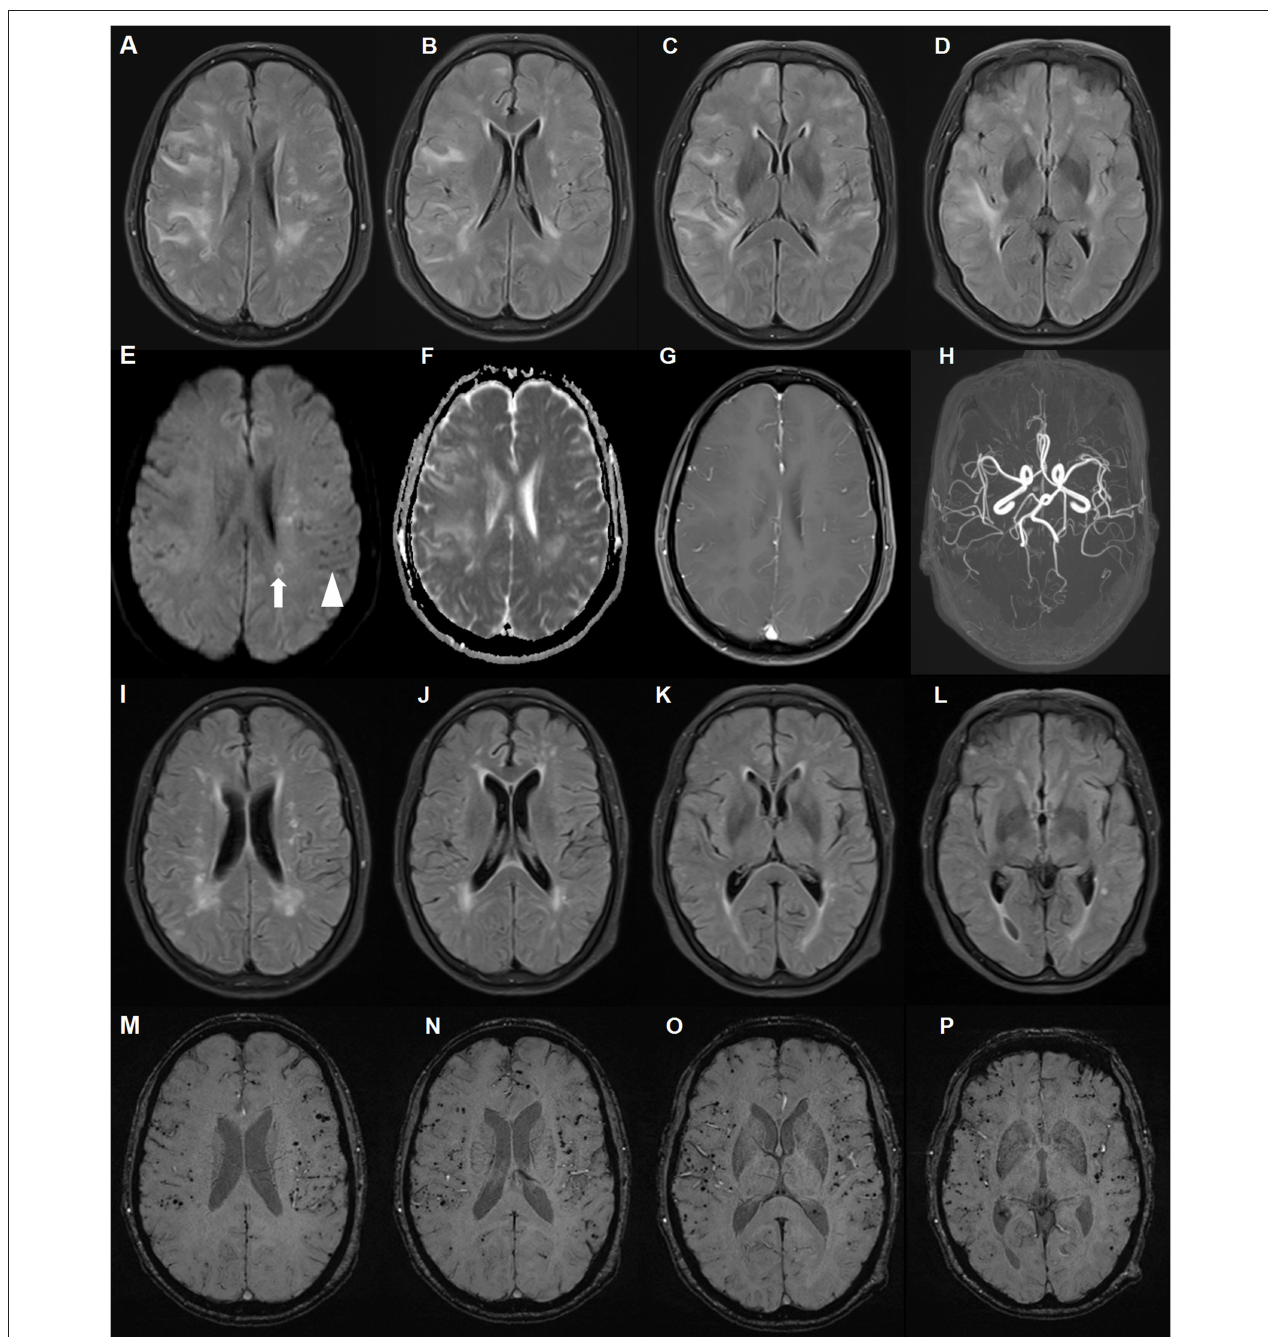
FIGURE 1 | Brain magnetic resonance imaging (MRI) of a patient with cerebral amyloid angiopathy (CAA)-related inflammation (CAA-RI) with the ApoE ε 2/ ε 2 genotype. Before glucocorticoid treatment, axial fluid attenuated inversion-recovery (FLAIR) (A–D) sequences revealing multiple, asymmetrical subcortical white matter lesions, predominantly in the left lobe. The lesions are isointense on diffusion-weighted imaging (DWI) sequence (E) , hyperintense on apparent diffusion coefficient (ADC) (F) and without parenchymal enhancement (G) . MRA did not reveal abnormalities (H) . Scattered hypointense lacunae (arrow head) and iso-hyperintense lesions (arrow) on the DWI sequence indicating microbleeds and subacute ischemia. On the follow-up MRI 2 months later, FLAIR lesions largely disappeared after glucocorticoid treatment (I–L) . Susceptibility weighted imaging revealed no changes in diffuse microbleeds (M–P)